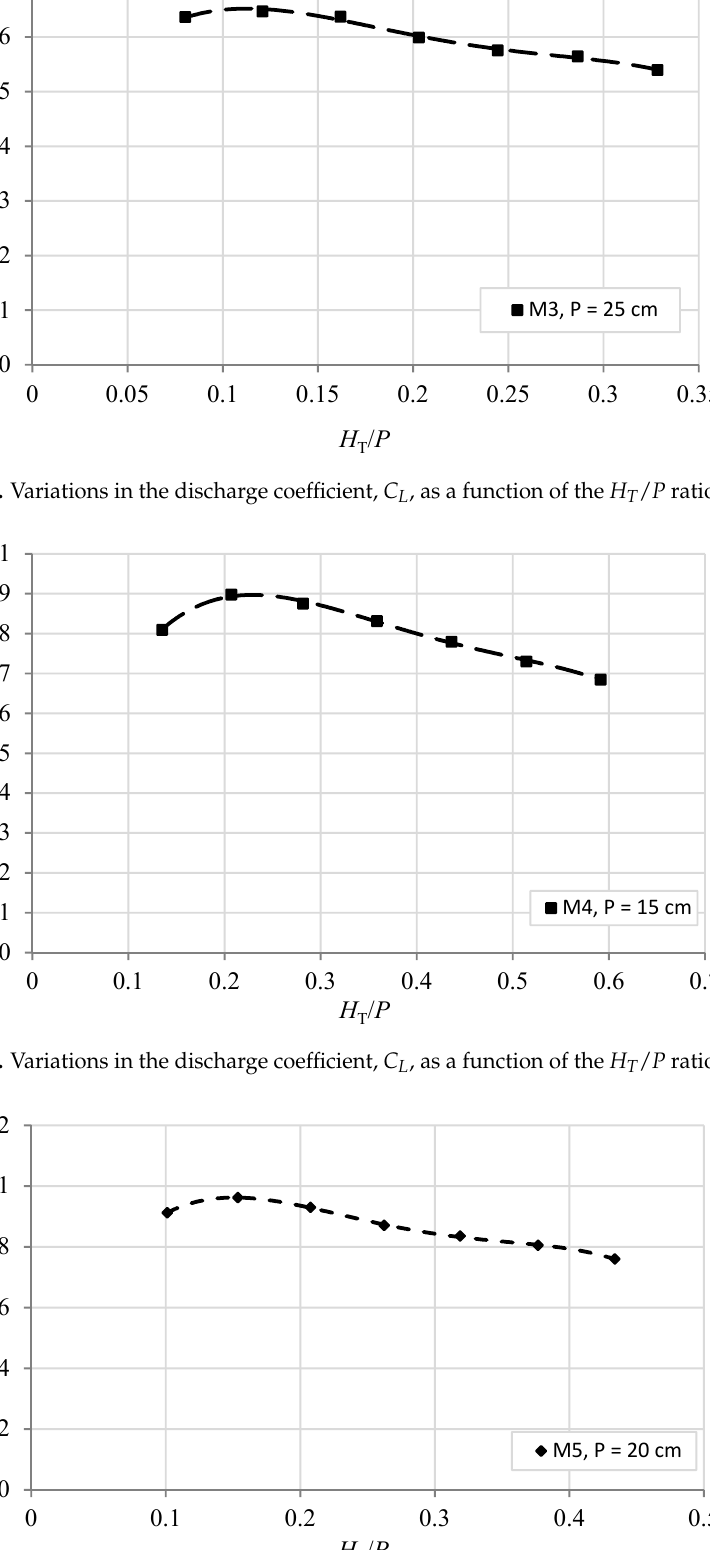
Figure 6. Variations in the discharge coefficient, C L , as a function of the H T /P ratio for the M2 model.